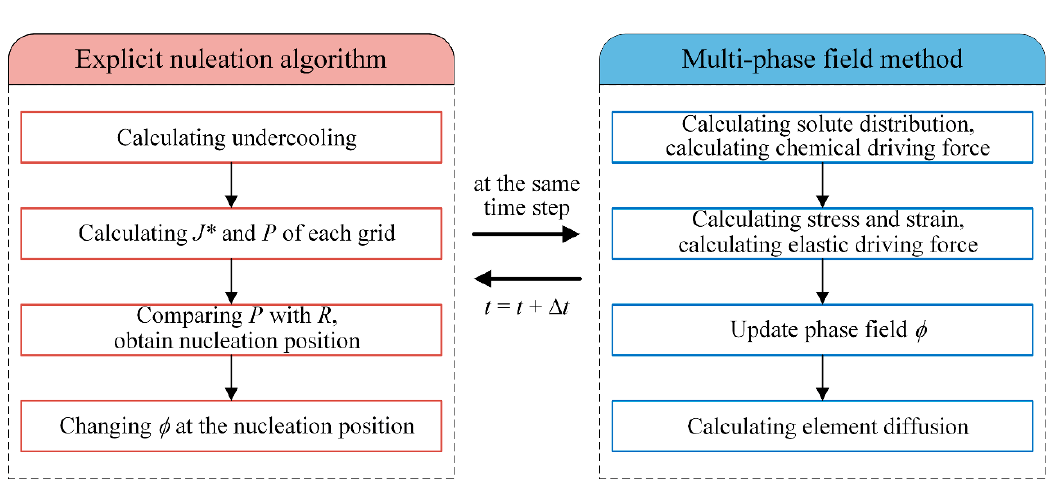
Table 1. Chemical composition of DD6 superalloy.